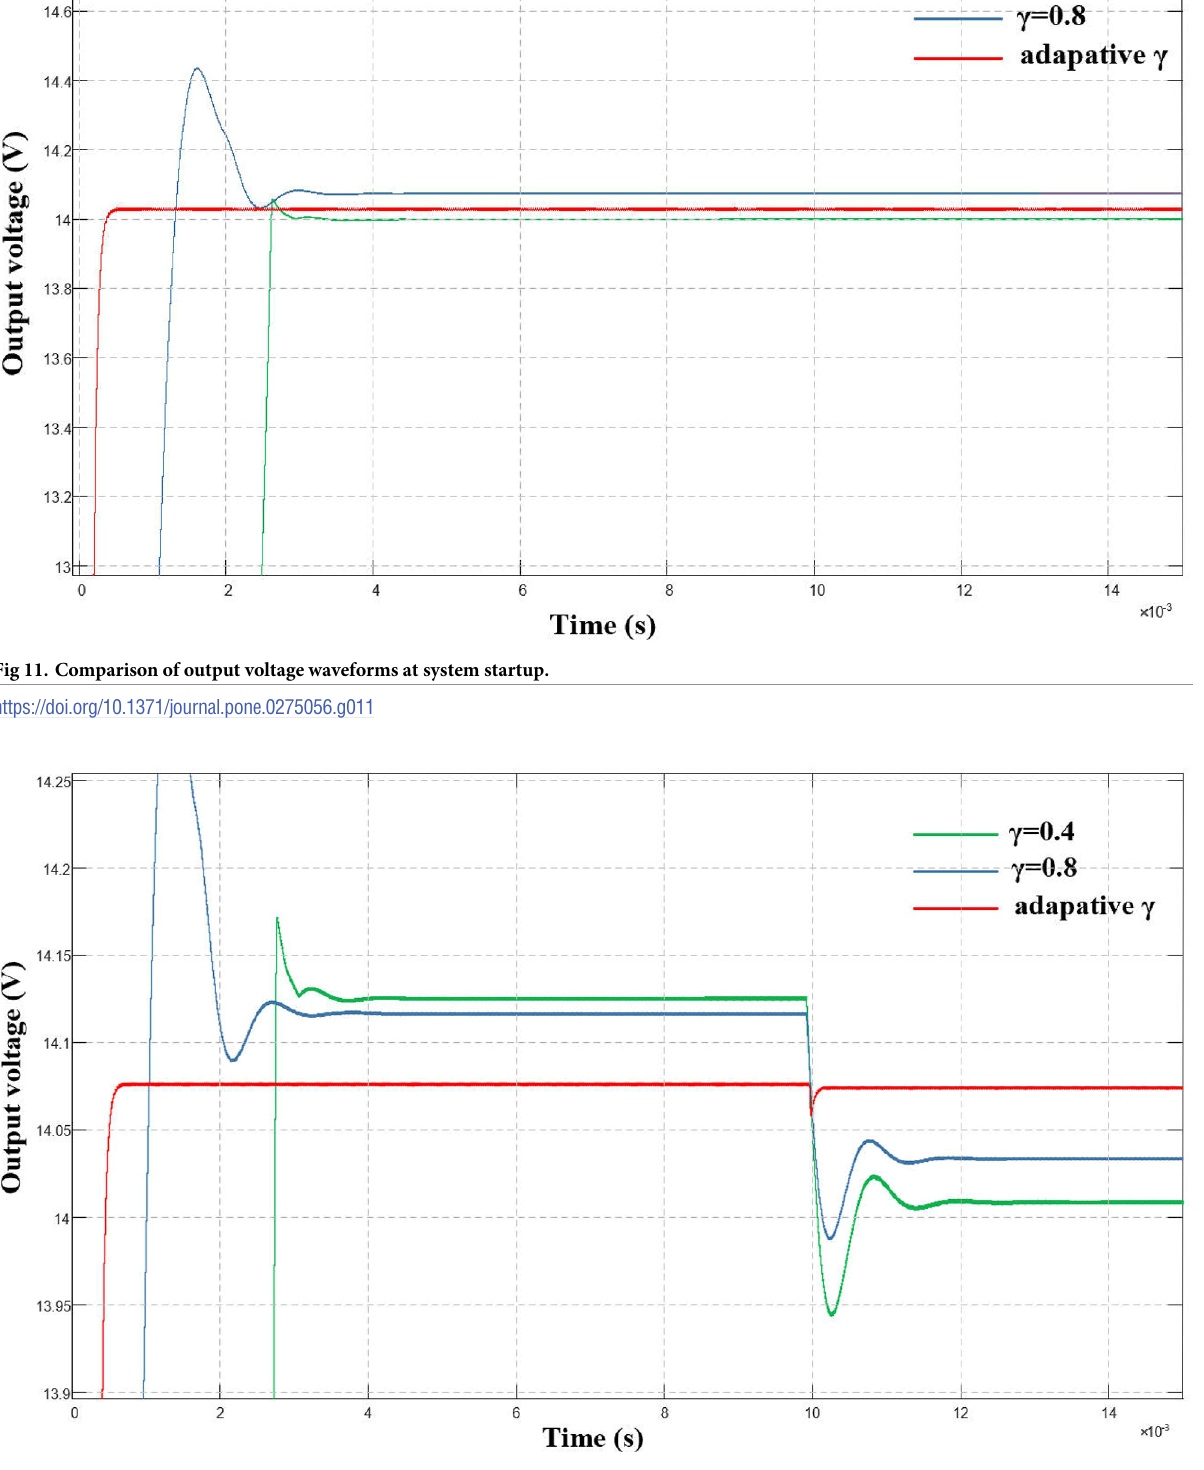
Fig 12. Comparison of output voltage waveform under load disturbance.